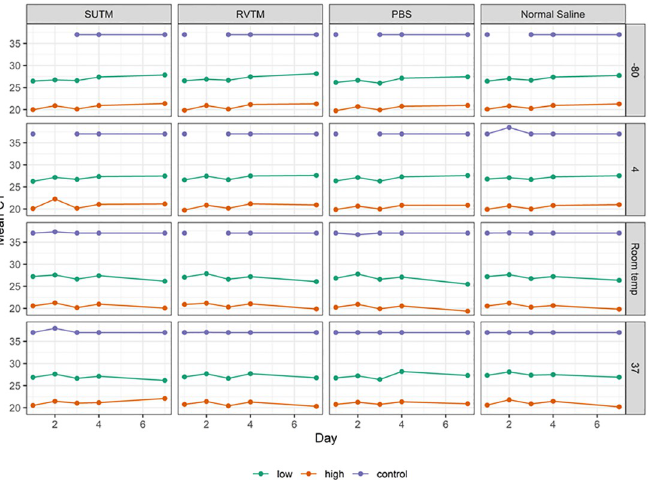
Fig 2. Mean Ct values for the four media types over time (in days) at -80 º C, 4 º C, room temperature (25 º C) and 37 º C stratified by concentration. A Ct > 36 or 37 indicates a negative result. The gaps in temperatures -80˚C and 4˚C indicate the negative samples, these were samples with Ct < 36, which were excluded from the analyses. Each data point is the mean of 4 samples, the 2 high and 2 low concentration samples assayed in duplicate and the negative control sample data points are the mean of the